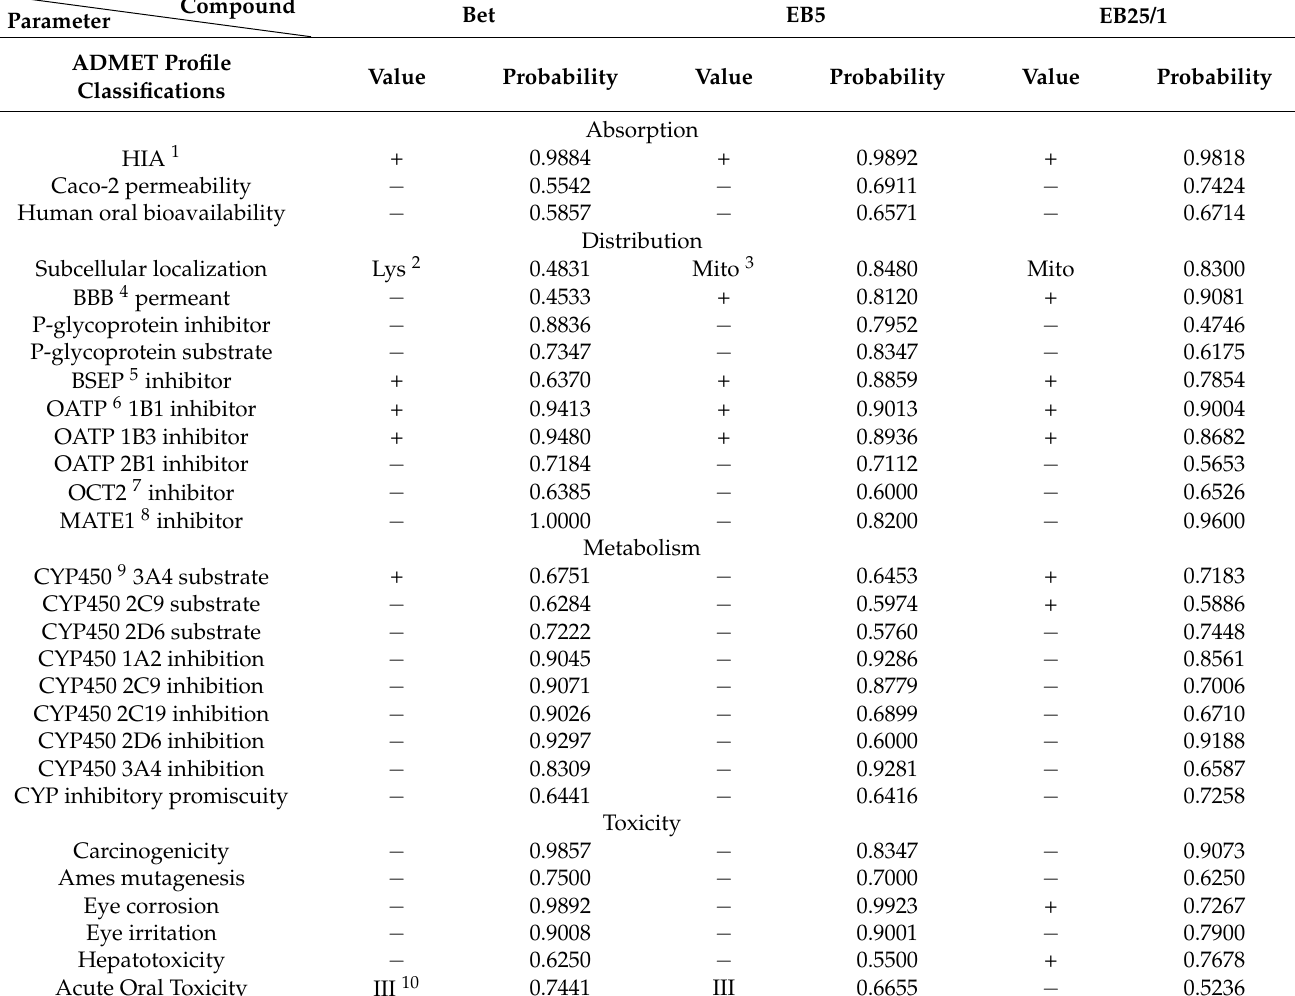
Table 4. Pharmacokinetic parameters of Bet and ASBDs—computational predictions of ADMET